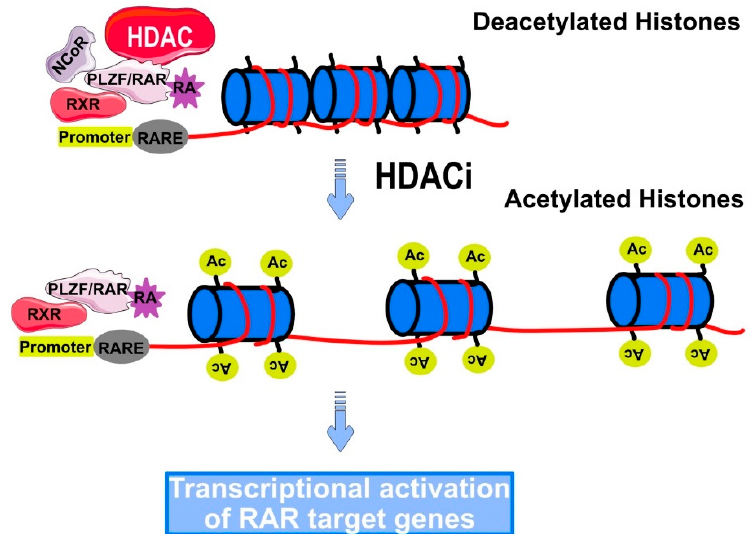
Figure 5. Recruitment of HDAC to retinoic acid-responsive elements (RARE) in Promyelocytic leukemia (PML). HDAC forms a multiprotein complex with RAR-PLZF, resulting in the transcriptional repression of retinoic acid receptor (RAR) target gene, responsible for normal differentiation and proliferation of myeloid cells. HDACi can reverse this case by restoring the sensitivity of PML to retinoic acids.